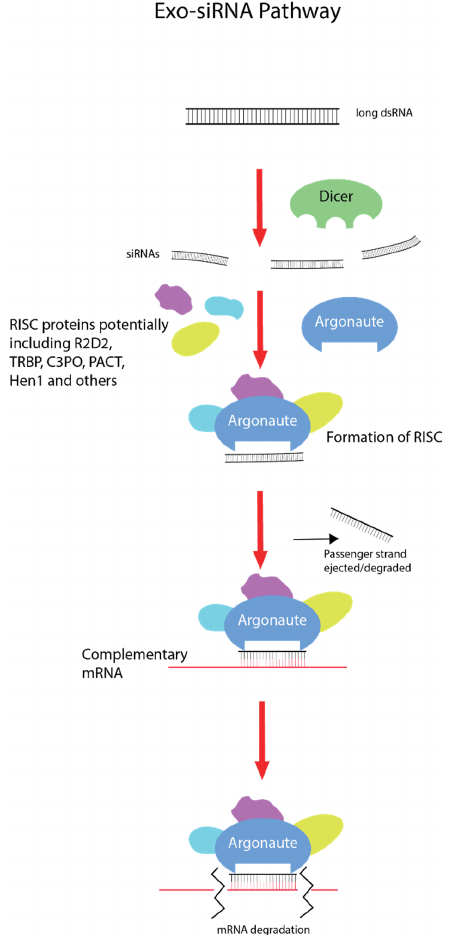
Figure 1. Exogenous small interfering RNA pathway (exo-SiRNA). Double-stranded RNA (dsRNA) enters the cell via di ff erent uptake mechanisms depending on the taxa. Long dsRNA molecules are bound by Dicer proteins, which cleave them into small 21–23 nucleotide double-stranded RNA duplexes called small interfering RNAs (siRNA). With the assistance of partner proteins such as R2D2 (varying across lineages), these siRNA molecules are loaded with Argonaute proteins and others (again dependent on lineage) to form the RNA-induced silencing complex (RISC). The RISC will then unwind and discard the passenger RNA strand and survey the cytoplasm for the homologous mRNA molecule. Once this mRNA is found, the guide RNA strand binds via Watson–Crick base pairing and Argonaute degrades the transcript, e ff ectively silencing the